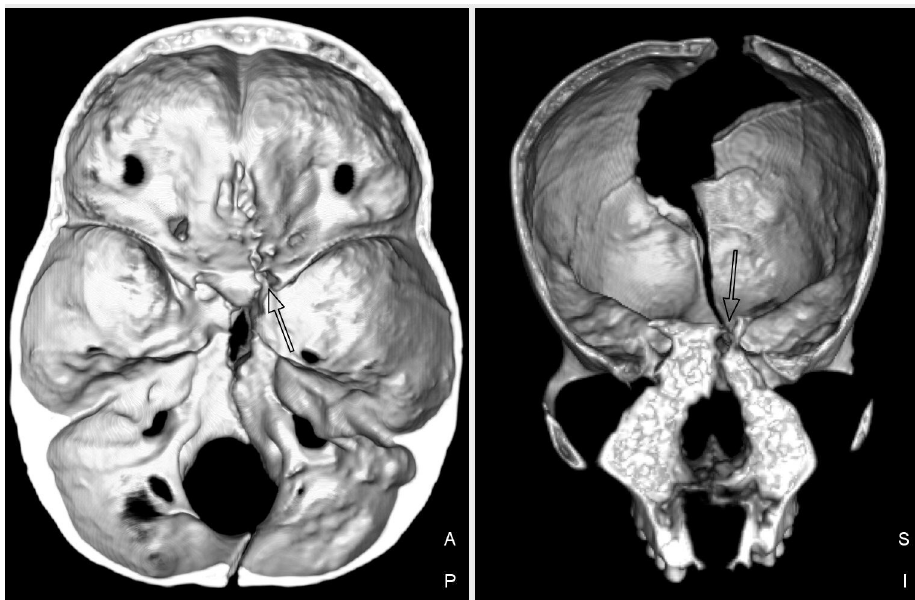
Fig 6. CT scan of Individual 1, SAM-AP 6421, showing cleaved sphenoid.